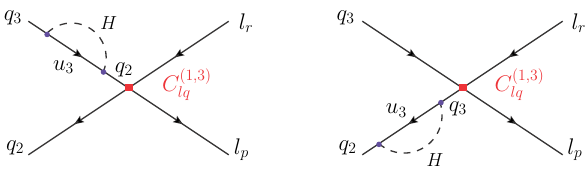
Fig. 4 RGE-inducedmixingoftheoperators O ( 1 , 3 ) indices ( 22 ) and ( 33 ) , into the same operator with indices ( 23 ) , which contributes to R K ( ∗